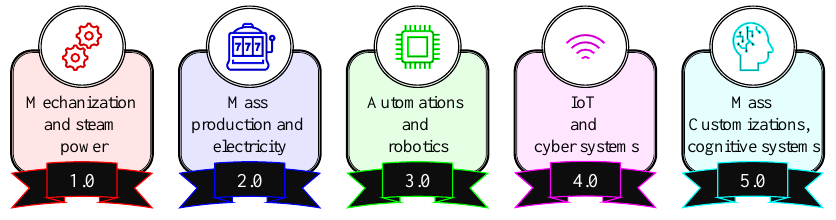
Figure 2. Evolution of industry from 1.0 to